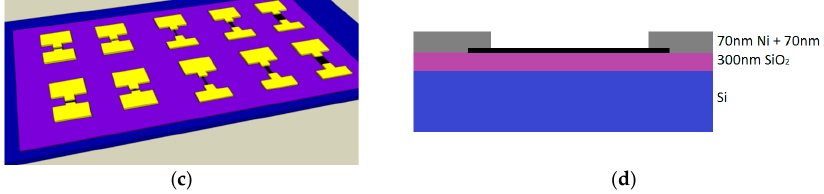
Figure 9. ( a ) The signal with illumination by a 10.1 µW X-ray source over time for a graphene FET based on a silicon carbide substrate (reproduced from [49] with permission of AIP Publishing under a This shows slow illumination and slow decay for an X-ray photon beam, The same group have also shown the sensitivity of a graphene FET based on a silicon substrate at 4.3 K [48]; ( b ) the funnelling of charge carriers towards the substrate dielectric with the application of a gate voltage. In this simulation the charge carriers are funnelled towards 5 contacts on the substrate surface of increasing size; ( c ) shows the the design of an X-ray GFET test device; here blue is Si, light purple is SiO 2 , yellow is the Ni-Al contact and black is the graphene of different channel sizes for each device, with another, side-on, schematic shown in Figure 9d.